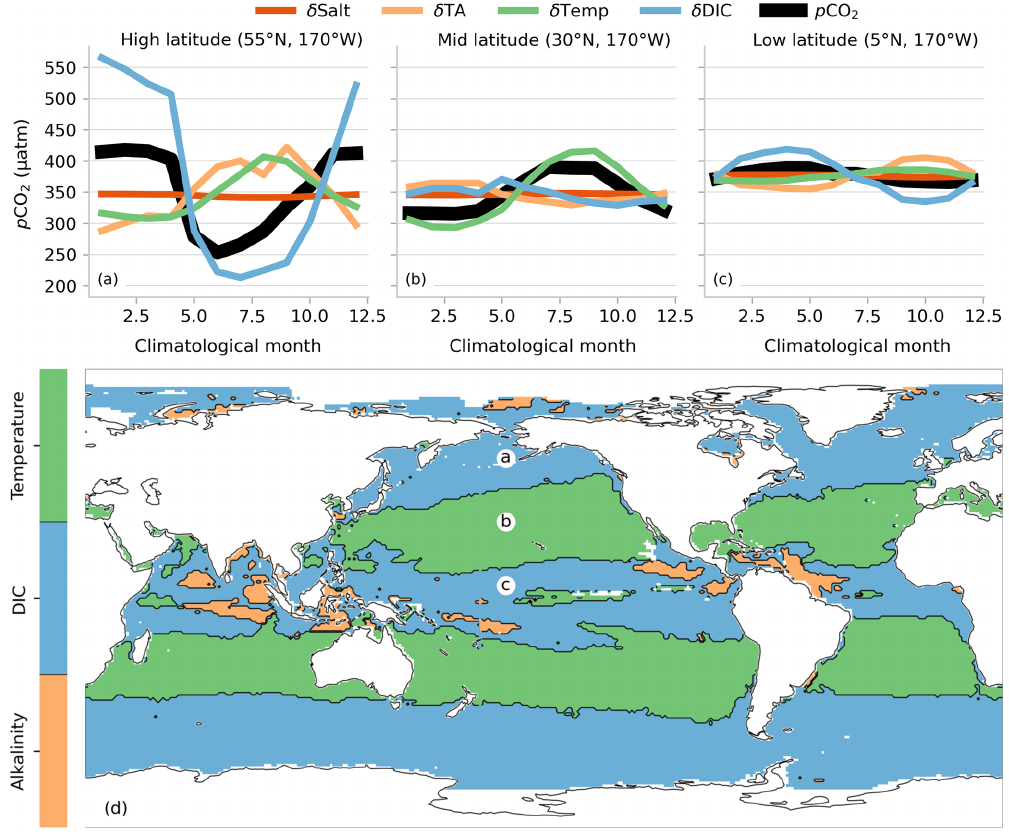
Figure 12. Attribution of DIC, TA, and temperature to the seasonal cycle of p CO 2 . The top two figures show the seasonal cycle of p CO 2 and the drivers thereof for (a) high latitudes, (b) midlatitudes, and (c) low latitudes. These locations are shown with the markers in the Pacific Ocean in panel (c) . The map (d) shows the dominant driver of the seasonal cycle for each region calculated as the value with the maximum seasonal